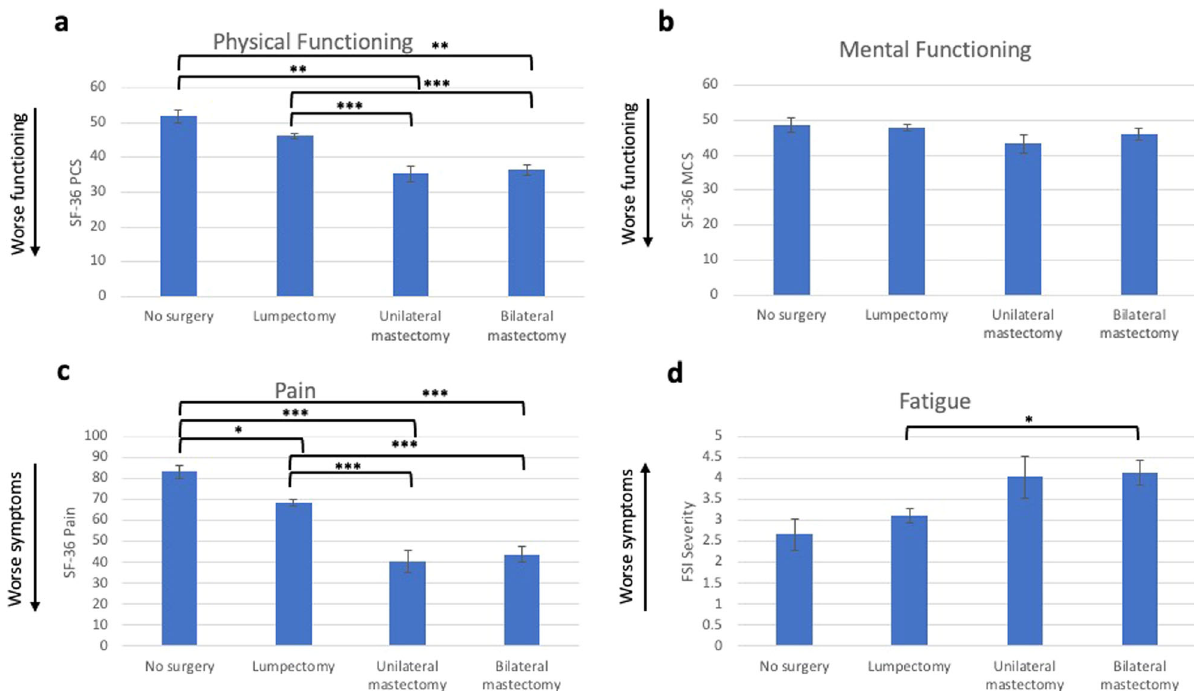
Fig. 3 Study 2 HRQOL outcomes. Average levels of physical functioning ( a ), mental functioning ( b ), pain ( c ), and fatigue ( d ) are presented with error bars representing standard errors. Statistically signi fi cant differences between groups using ANCOVA are represented by bars (* = p < 0.05, ** = p < 0.01, *** = p < 0.001).